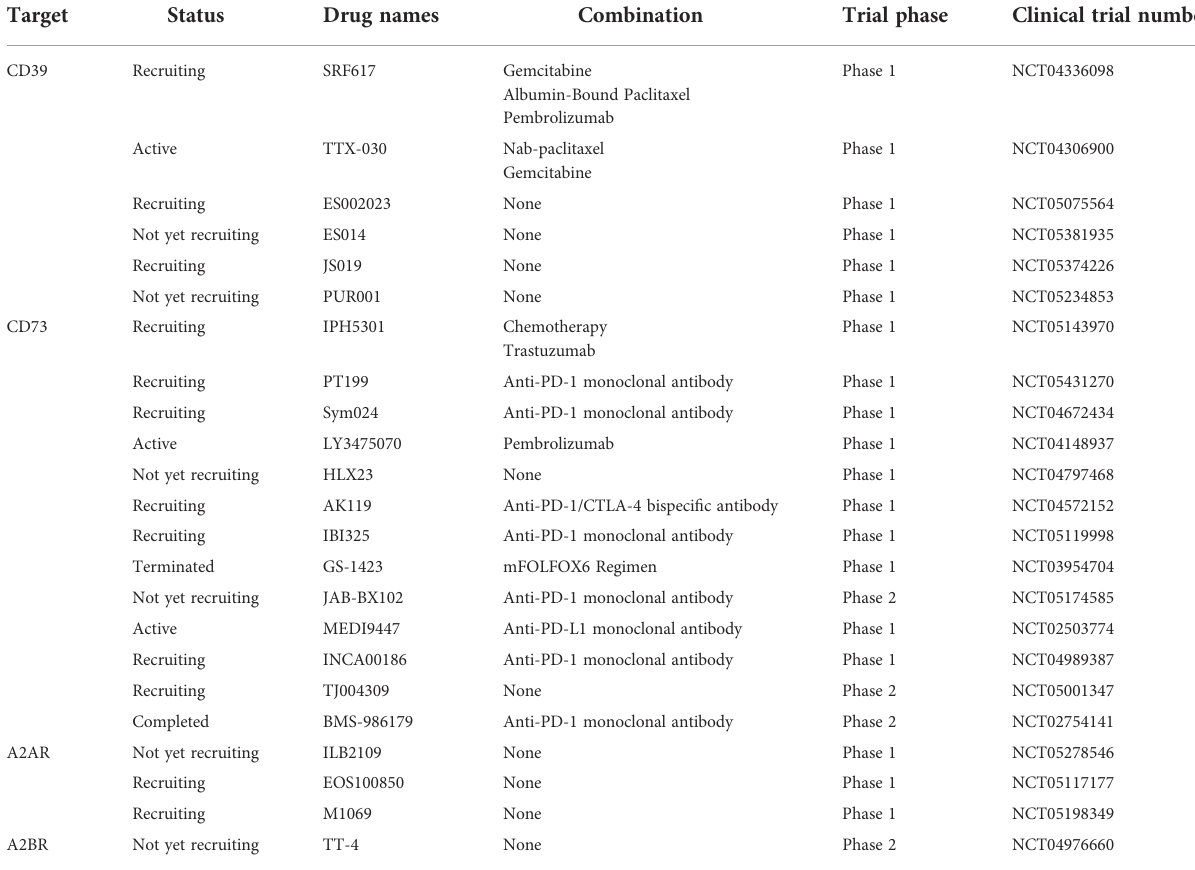
TABLE 2 The clinical trials of blocking adenosine signaling in patients with advanced solid tumors.